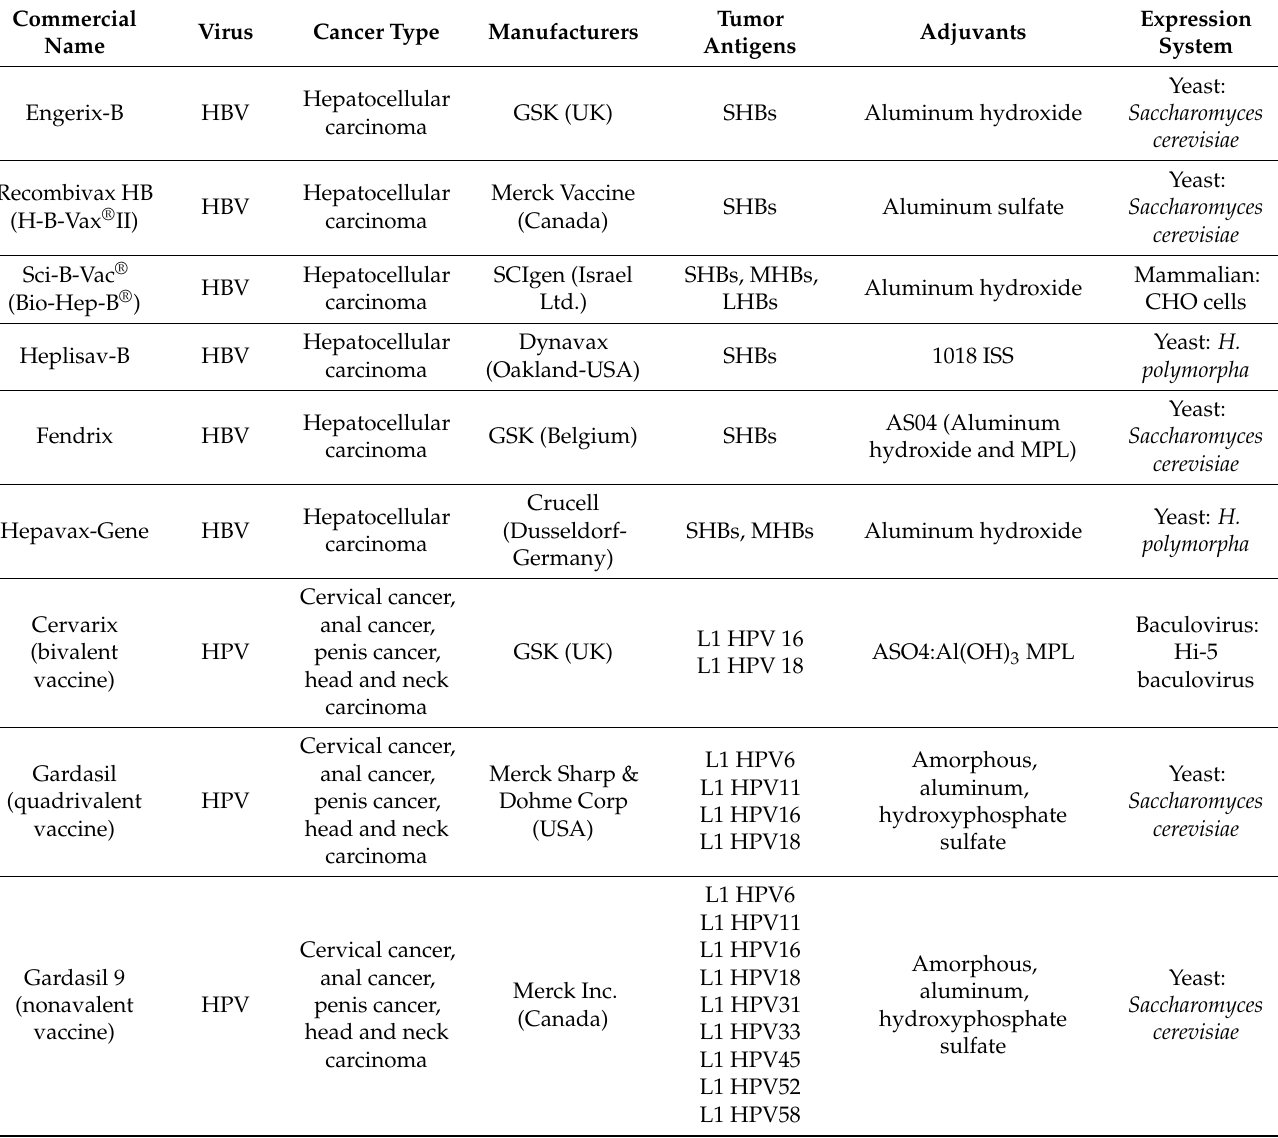
Table 1. Licensed prophylactic VLP vaccine against